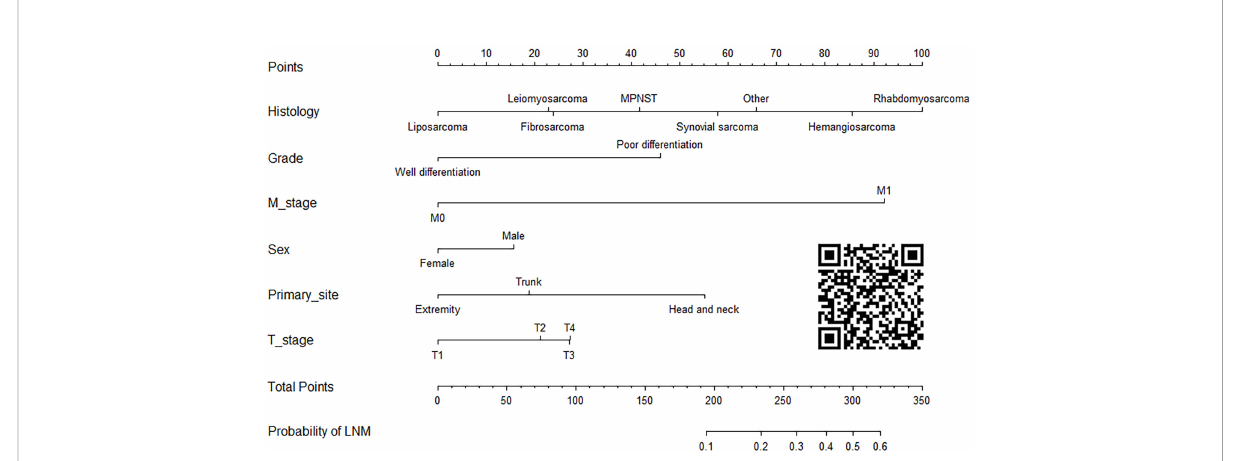
FIGURE 3 A diagnostic nomogram for quantifying the probability of LNM in patients with STS.